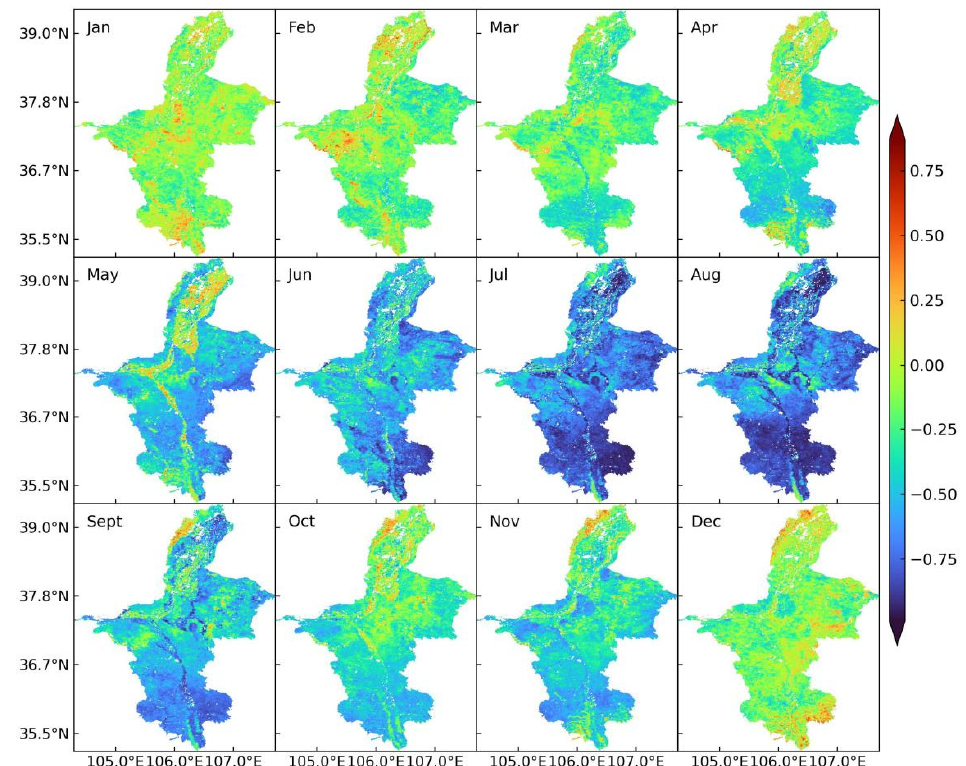
Figure 14. Spatial distribution of the correlation coefficient between EDI and NDVI.